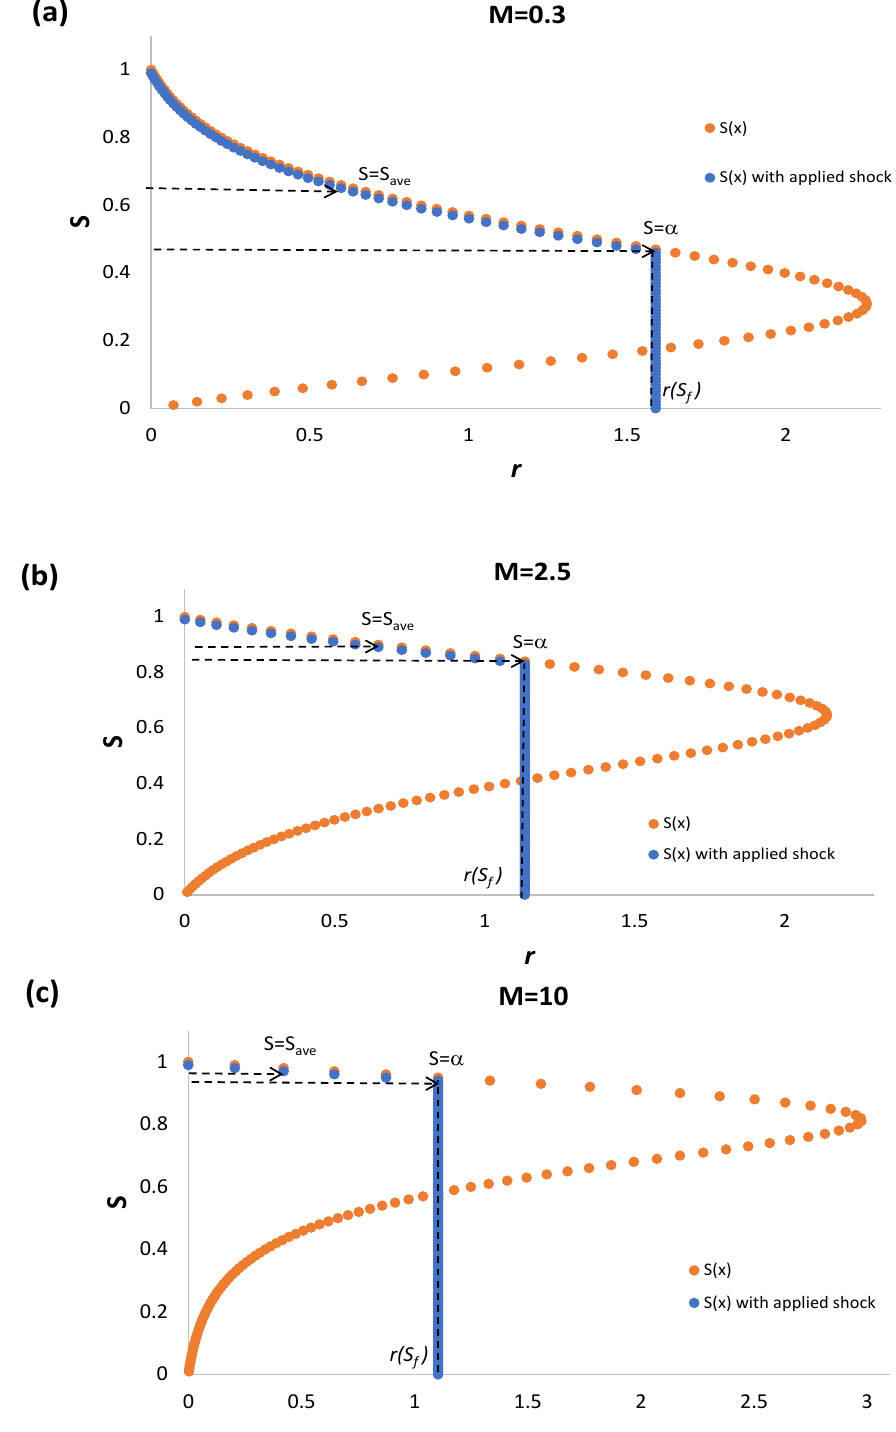
Figure 9. Saturation as a function of propagation speed for three mobility ratios ( a ) M = 0.3, ( b ) M = 2.5, and ( c ) M = 10, illustrating the location of the